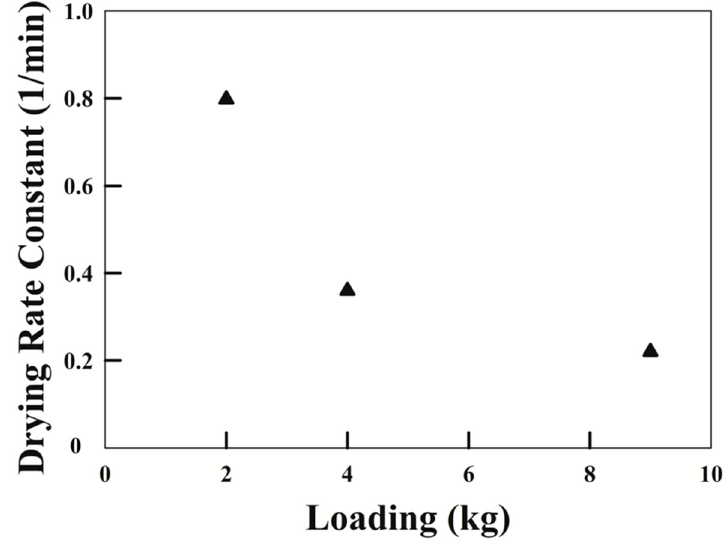
Figure 12. Drying rate constant versus WG loading during drying with different loadings, from 2 to 9 kg, at 120 °C.